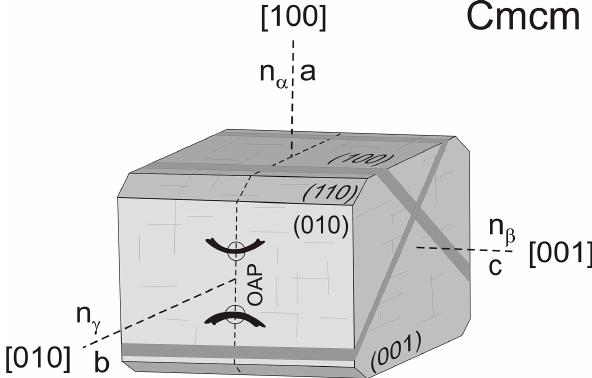
Figure 1. Anhydrite crystal structure, optical properties, and mor- phology modified after Tröger (1971). Miller indices hold for space group Cmcm following Hildyard et al. (2011). Note that this nota- tion is different from that used in earlier studies on anhydrite rheol-